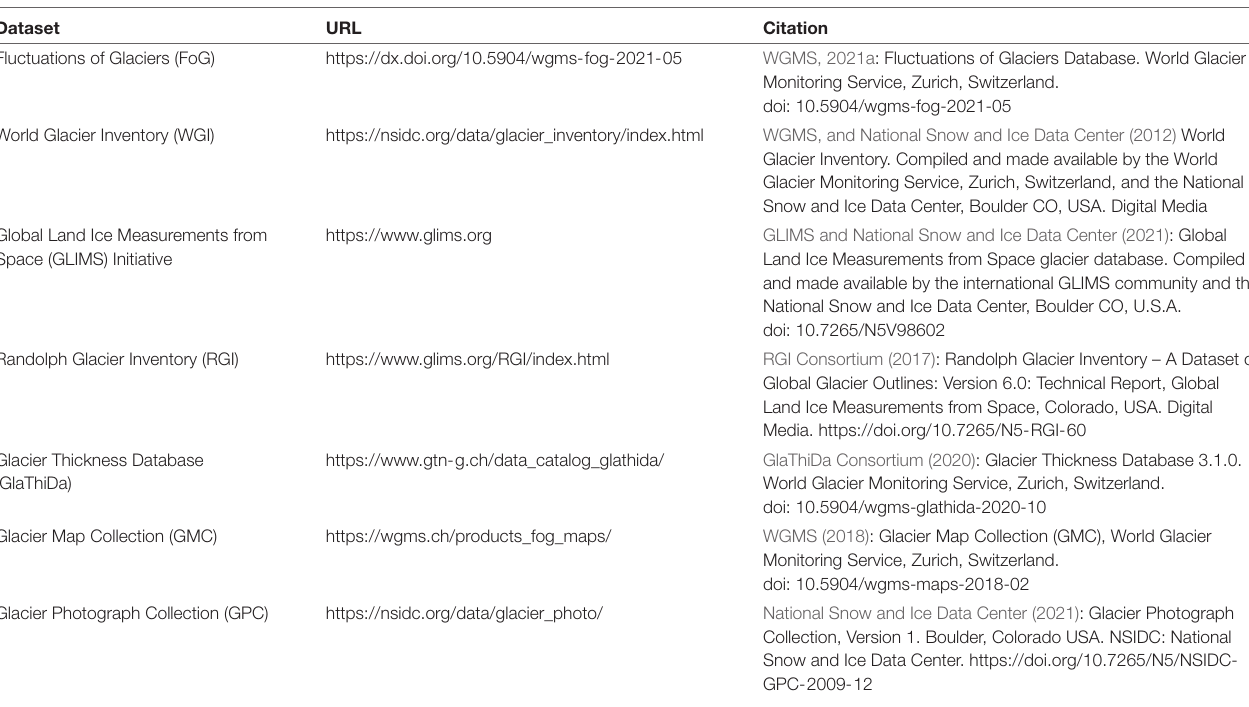
Glacier Photograph Collection